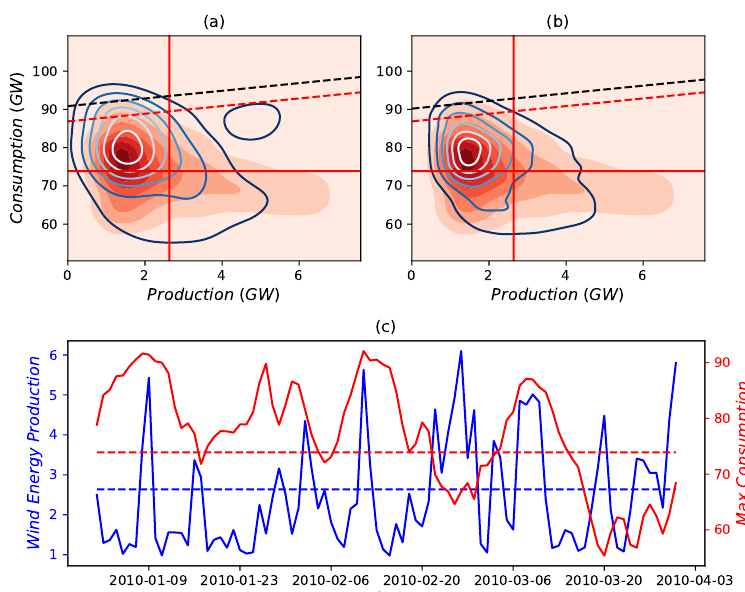
Figure 5. Blue contour lines show ( a ) the real and ( b ) the reconstructed joint PDF for winter 2010. Red shading show the winter climatological joint PDF. Red vertical and horizontal lines correspond respectively to the mean production and mean consumption given by climatology. Red dashed line shows the VaR 95 of Co − Pr given by the climatological joint PDF, black dashed lines show the VaR 95 of Co − Pr given by ( a ) the real and ( b ) the reconstructed joint PDF. ( c ) Time series of the wind energy production (in blue) and the temperature driven consumption (in red) during winter 2010. Dashed lines show the winter mean climatological value of the wind energy production (in blue) and of the consumption (in